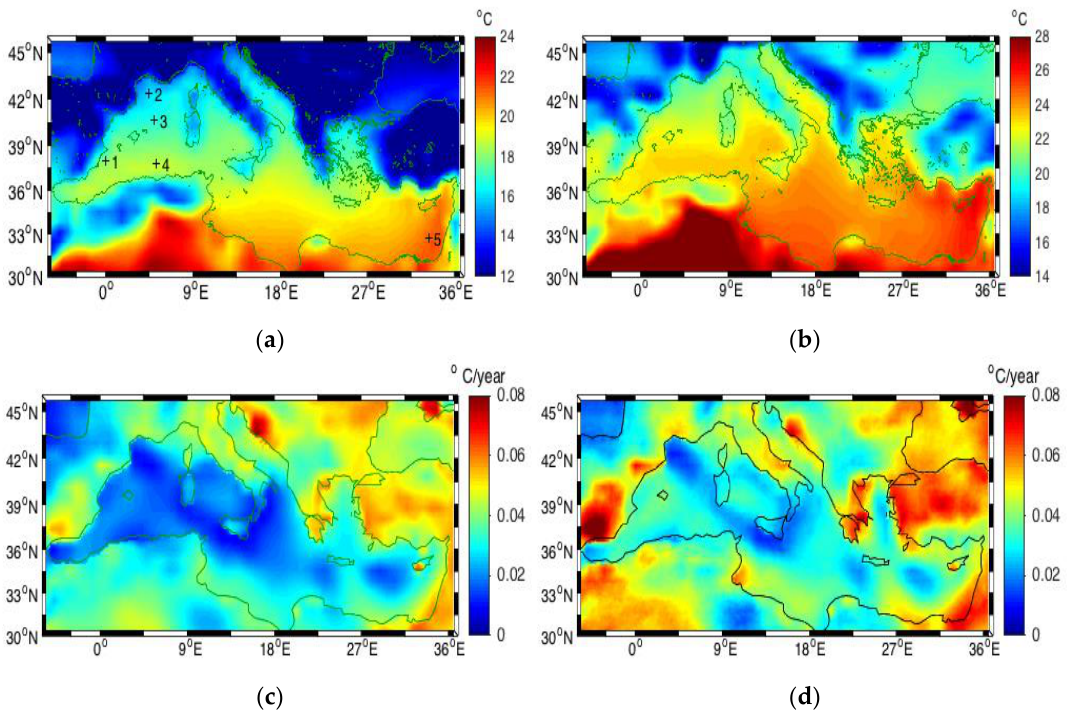
Figure 4. Air temperature in the MEDIT region: ( a ) 36-year averaged mean AT with 5 geographic locations indicated by crosses. Time series data for these sites are presented in the next figure to illustrate the temporal variability; ( b ) 36-year mean annual 75th percentiles for AT; ( c , d ) 36-year trends in the mean annual AT and 75th percentiles, respectively. Maps are based on the ERA Interim data (1982 – 2017).